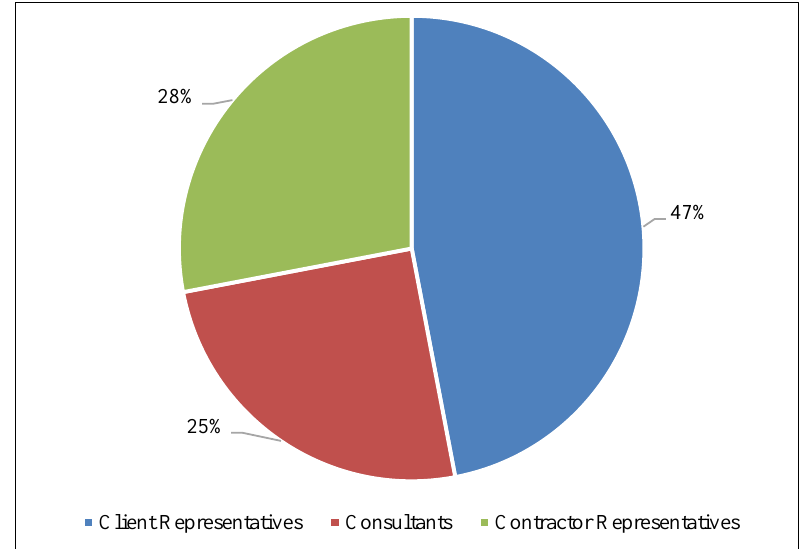
Figure 3. Percentage of responses from primary